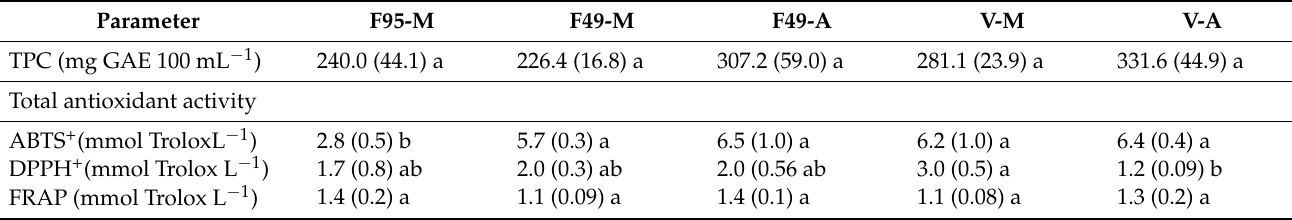
Table 6. Variations of the total content of polyphenols and the total antioxidant activity of lemons (“Fino 95”, “Fino 49” and “Verna”) obtained in different rootstocks ( C. macrophylla and C. aurantium ). The values represented are the mean with their standard deviation in